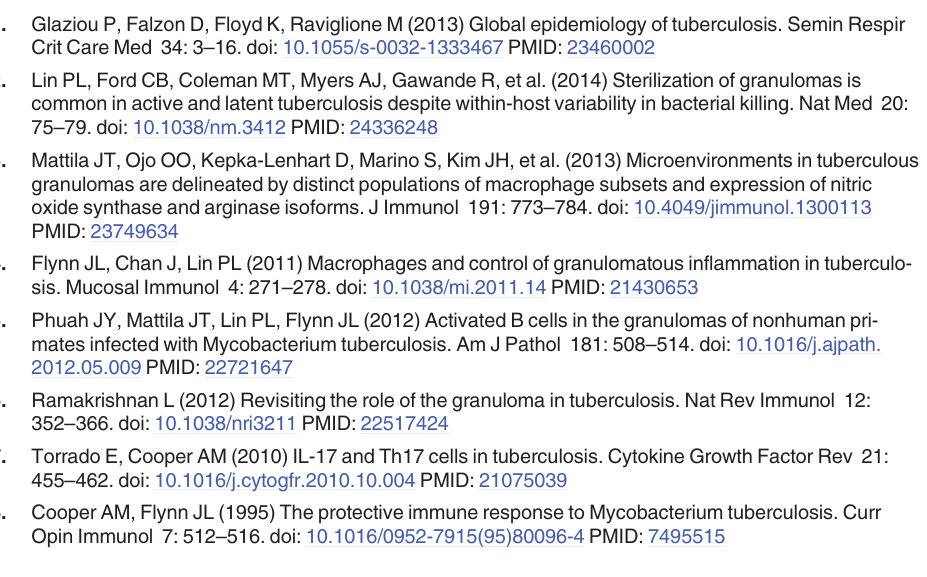
S1 Table. Correlation of total cell numbers, T cell counts and bacterial burden per granulo- ma with granuloma size. S2 Table. Pairwise correlation of cytokine levels within granulomas based on clinical states. S3 Table. Correlation of bacterial burden and T cell cytokine response based on clinical states. S4 Table. Correlation of average T cell cytokine response of granuloma of an animal and its systemic